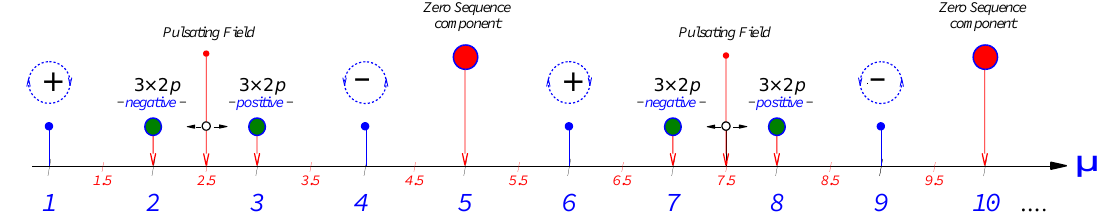
Figure 11. Time harmonics effect demonstration in three-phase machines.